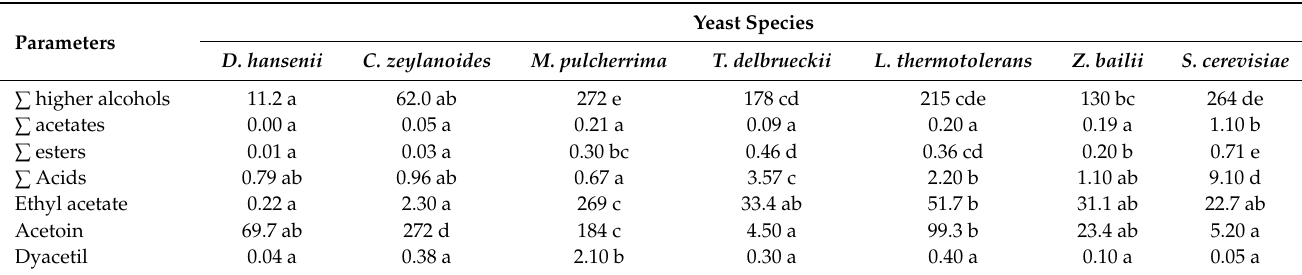
Table 4. Concentrations of aromatic compounds (mg/L) in wines made with different non- Saccharomyces yeast species and statistical analysis